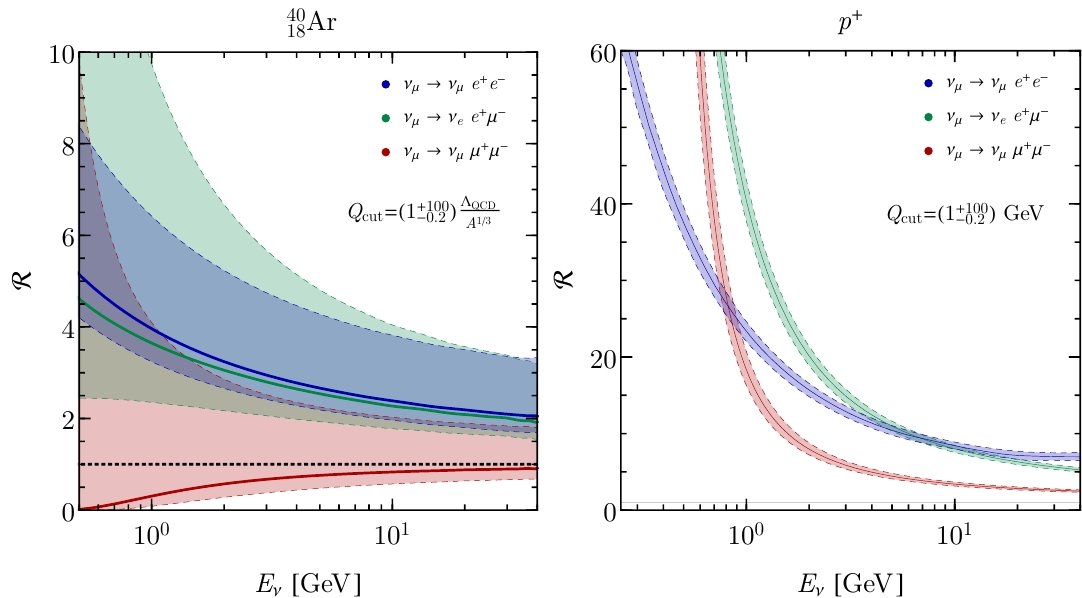
Figure 5 . Ratio R of the trident cross section calculated using the EPA to the full four-body calculation. Left panel: ratio in the coherent regime on 40 Ar. The full curves correspond to the central value of Q cut , and the upper (lower) boundary corresponds to a choice 100 times larger (20% smaller). Right panel: ratio in the di(cid:11)ractive regime for scattering on protons, where the full curves corresponds to the central value of 1 : 0 GeV, and the upper (lower) boundary corresponds to a choice 100 times larger (20% smaller); we have taken the lower limit in the integration on Q to match the choice of the coherent regime and we do not include Pauli blocking in these curves. A guide to the eye at R = 1 is also